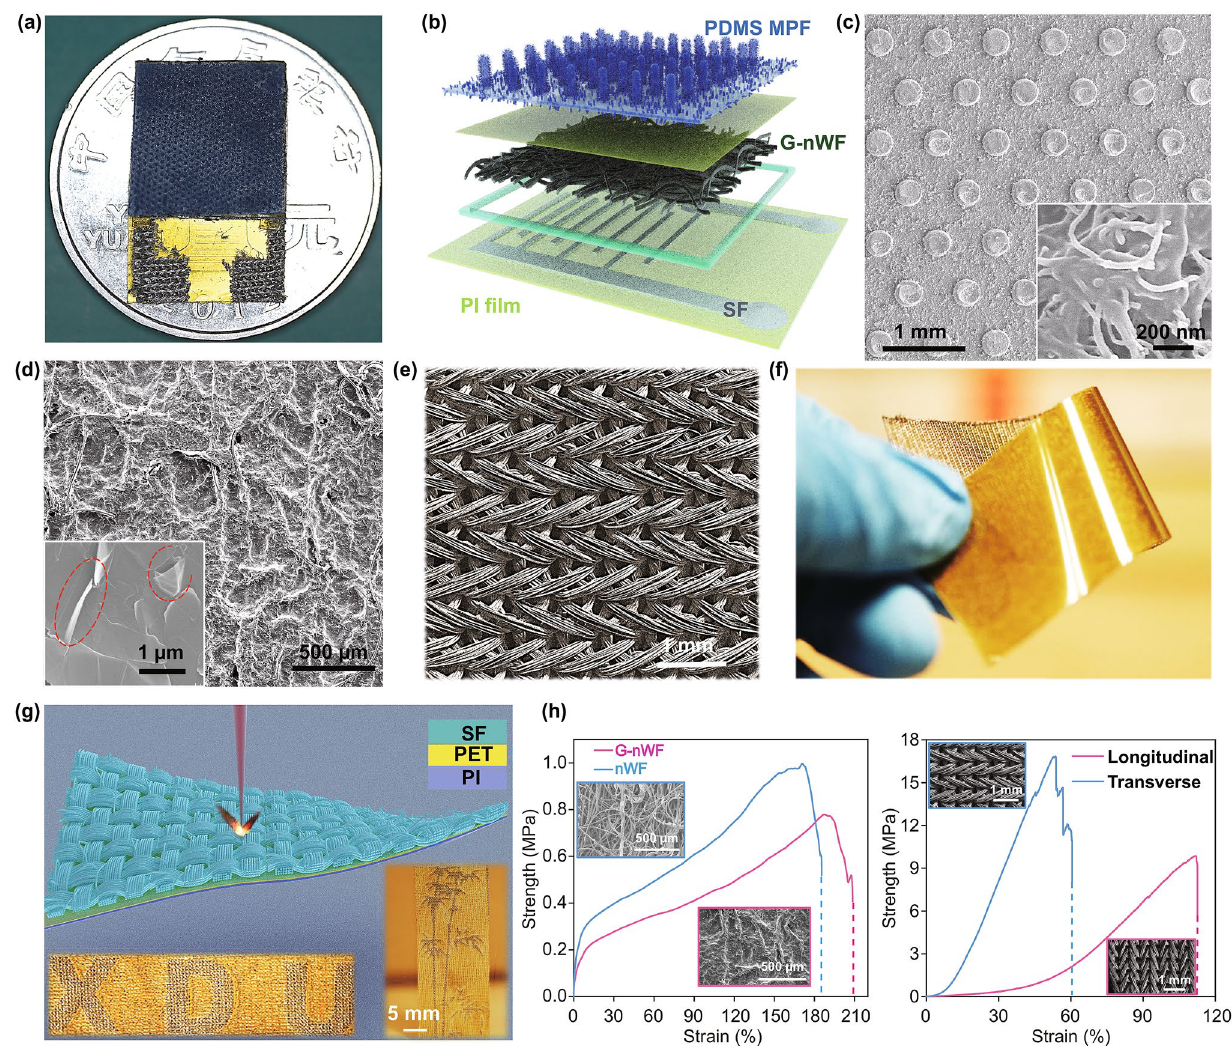
Fig. 2 Structural characterization of the flexible sensor. a Digital optical image of the sensor unit on a coin. b Detailed structural information of the sensor. c SEM image and corresponding large view of the PDMS MPF. d SEM image and corresponding large view of the G‑nWF. e SEM image of the SF with an ordered pattern. f Digital optical image of the ultra‑flexible SF mounted on PI film. g Schematic illustration of laser engraving of the SF. Inset showed various patterns that could be readily designed and fabricated, such as the “bamboo” and “XDU.” h Tensile test of the G‑nWF sensing materials and SF electrode, demonstrating the high